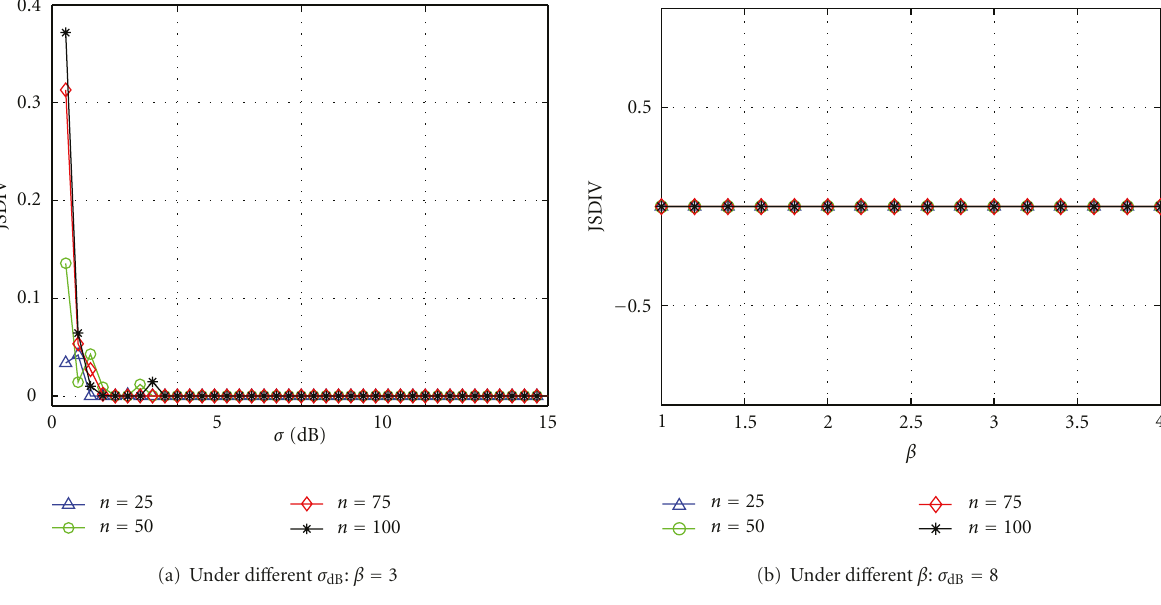
Figure 4: Jensen-Shannon divergence between f